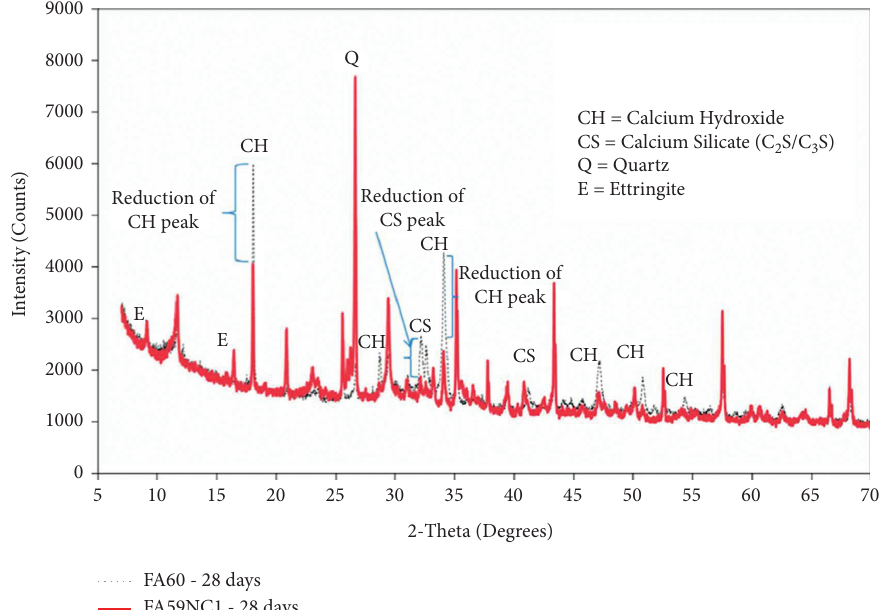
Figure 19: XRD analysis of HVFA pastes with and without nano-CaCO